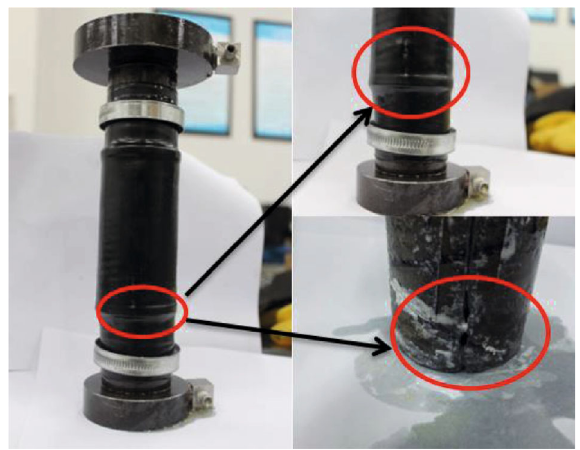
Figure 11: Thermoplastic pipe breakdown for high con fi ning pressure at sample depression.